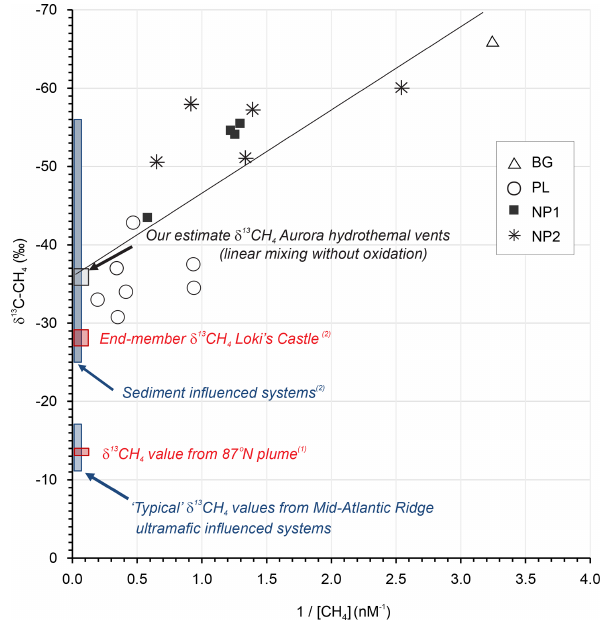
Figure 5. Keeling plot for δ 13 C-CH 4 versus 1 / [ CH 4 ] for the data obtained in background (BG), upper layer (UL), plume (PL) and non-plume (NP1–NP3) stations (Keeling, 1961; Keir et al., 2006). Plotted also are “closest approach” δ 13 C-CH 4 value reported for the 87 ◦ N hydrothermal plume on the Gakkel Ridge ( 1 McDermott et al., 2017), end-member hydrothermal fluid δ 13 C-CH 4 values from Mid-Atlantic Ridge black smoker systems known to be influenced by ultramafic rock, and the sediment-influenced Loki’s Castle sys- tem ( 2 Baumberger et al., 2016, and references